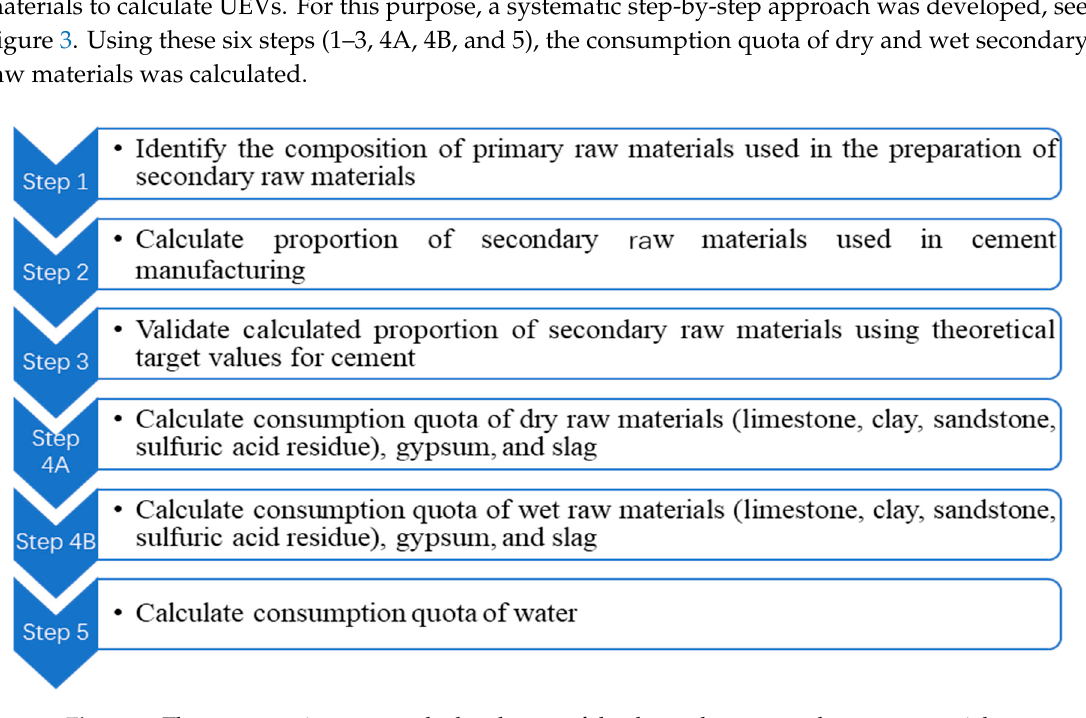
Figure 3. The consumption quota calculated steps of the dry and wet secondary raw materials.